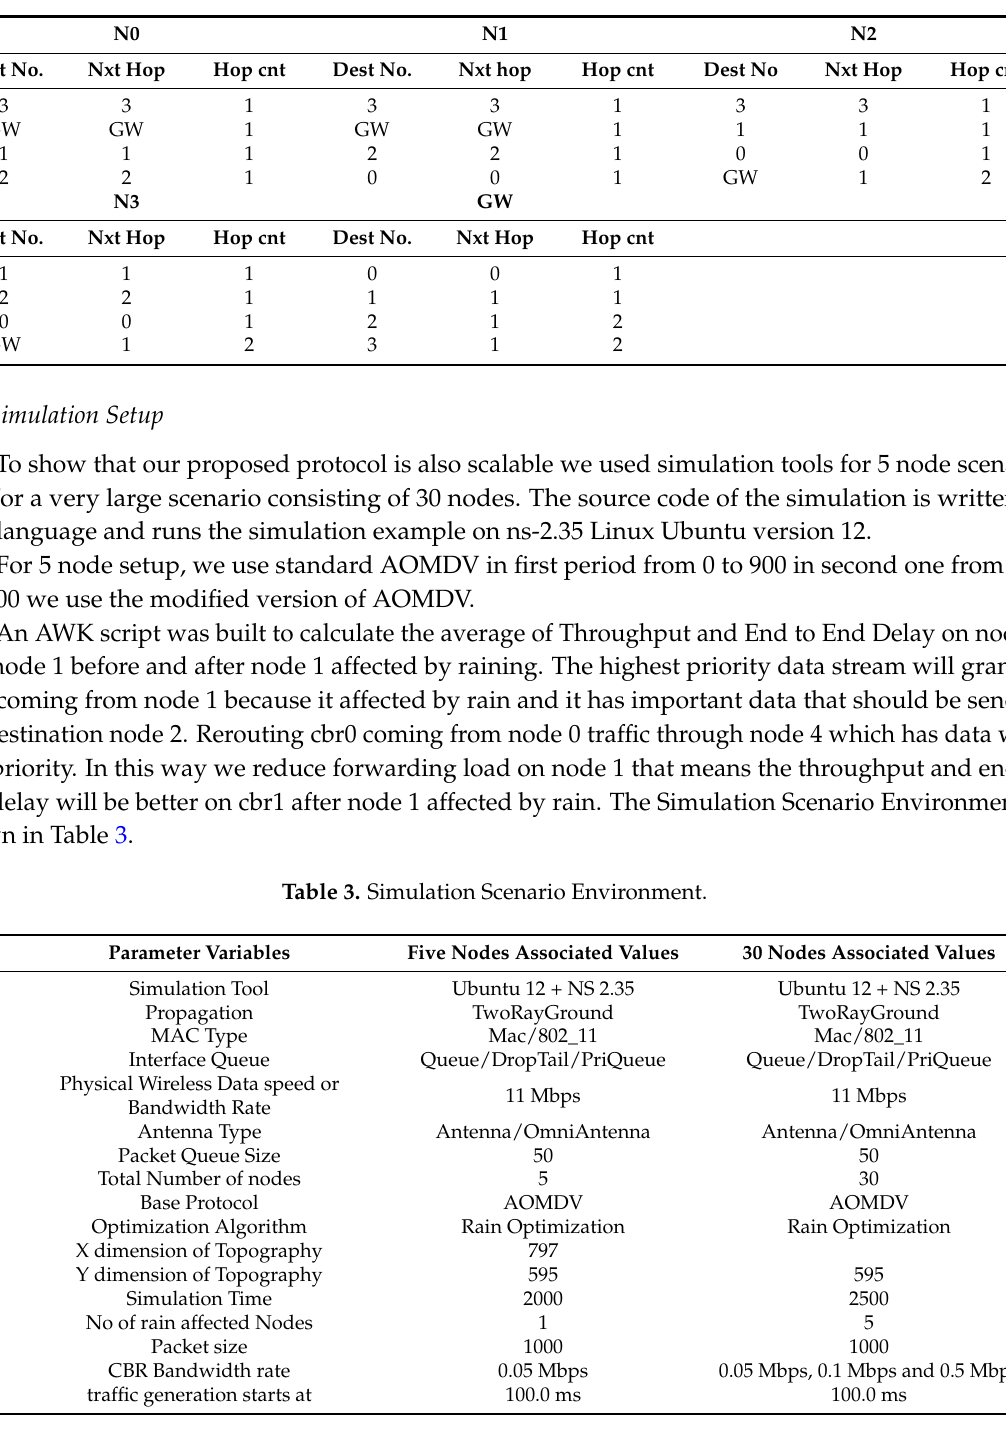
Table 2. Routing table after rain being detected at node 0.